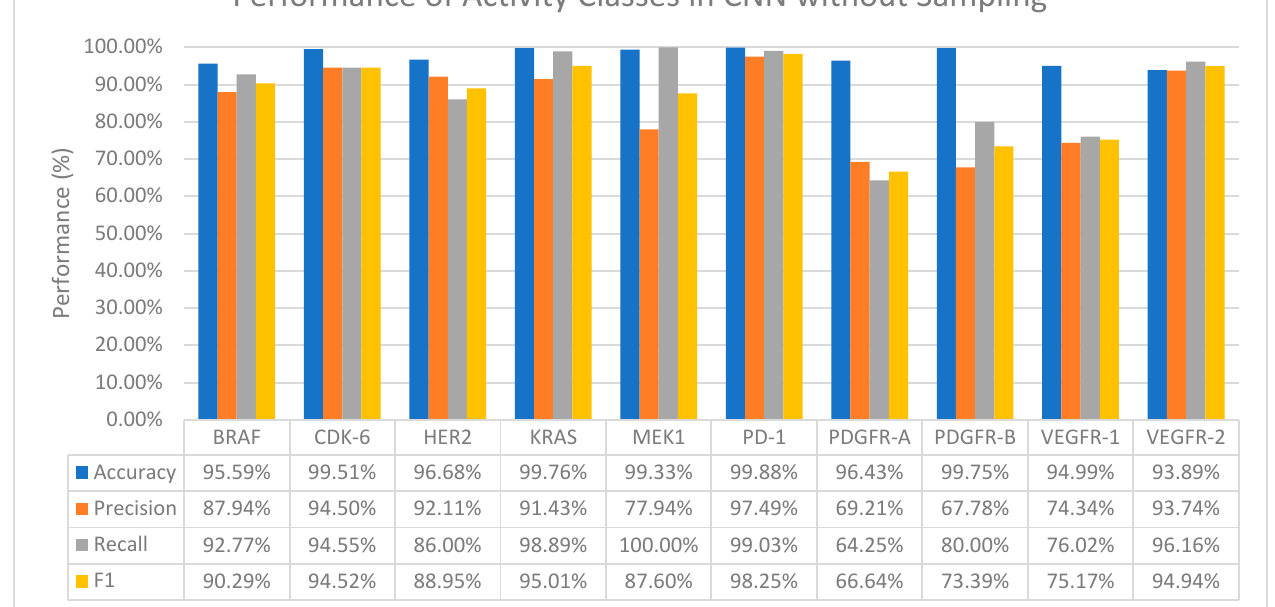
Figure 2. The performance of CNN in terms of accuracy, precision, recall and F1 score without sampling.